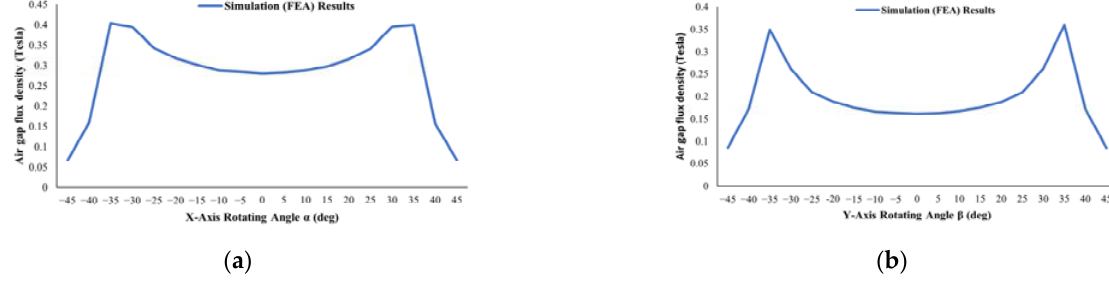
Figure 10. Magnetic flux density distributions in the air gap of the motor under loaded conditions rotating around the X ‐ axis from α = 0° to α = ±45° ( a ) and rotating around the Y ‐ axis from β = 0° to β = ±45° ( b ).